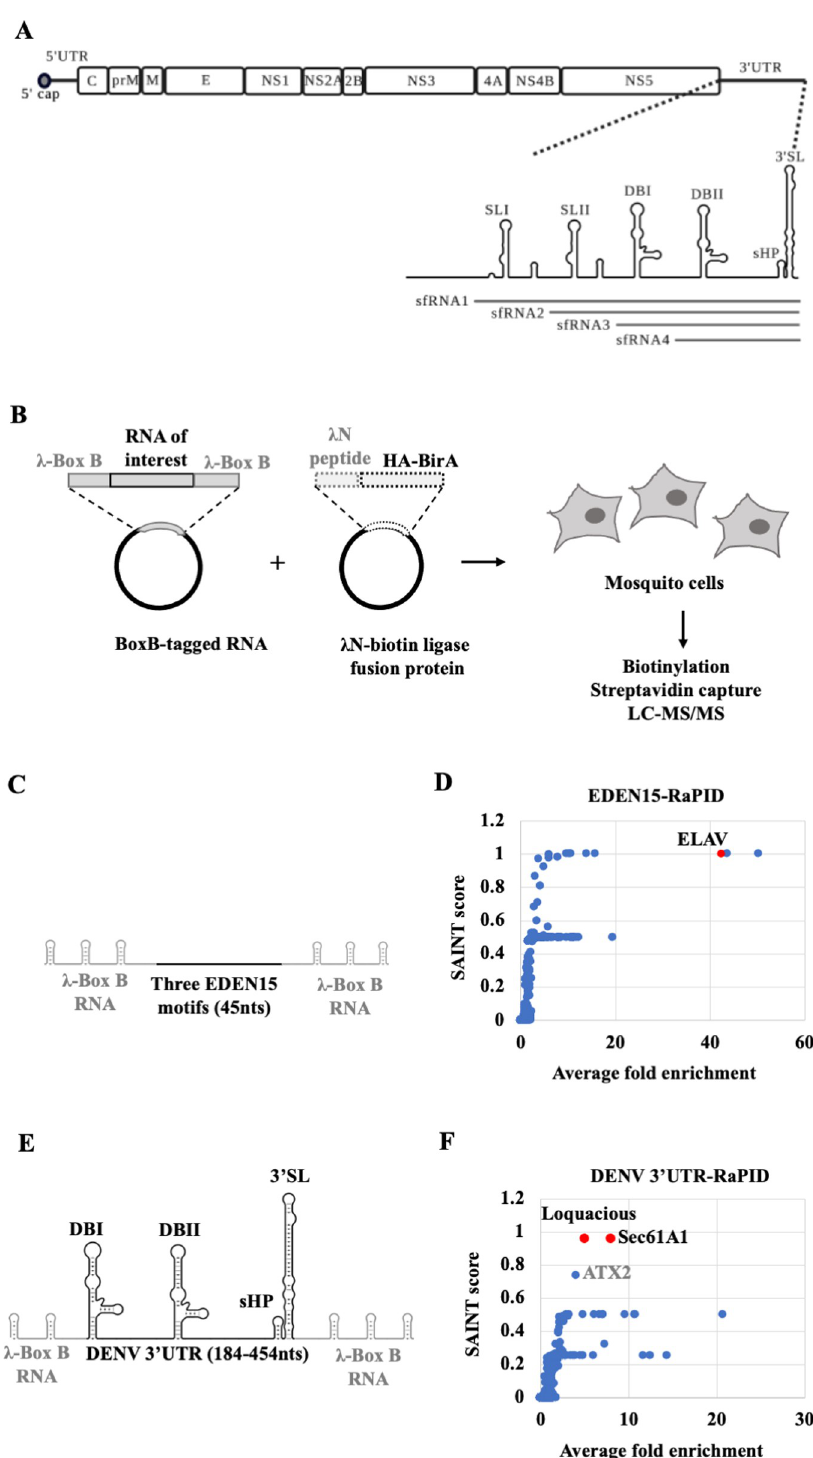
Fig 1. Diagram of the dengue viral (DENV) genome and strategy for the RNA-protein interaction (RAPID) assay. (A) DENV genome organization. The open reading frame encoding the three structural (C (capsid), prM/M (membrane), E (envelope)) proteins and seven non-structural (NS1, NS2A, NS2B, NS3, NS4A, NS4B, NS5) proteins flanked by 5’ and 3’ untranslated regions (UTR) are shown. The 3’ UTR is organized into stem loops SLI, SLII, dumbbell structures DBI, DBII, a small hairpin (sHP) and a terminal 3’ stem loop (3’SL). Subgenomic RNA fragments